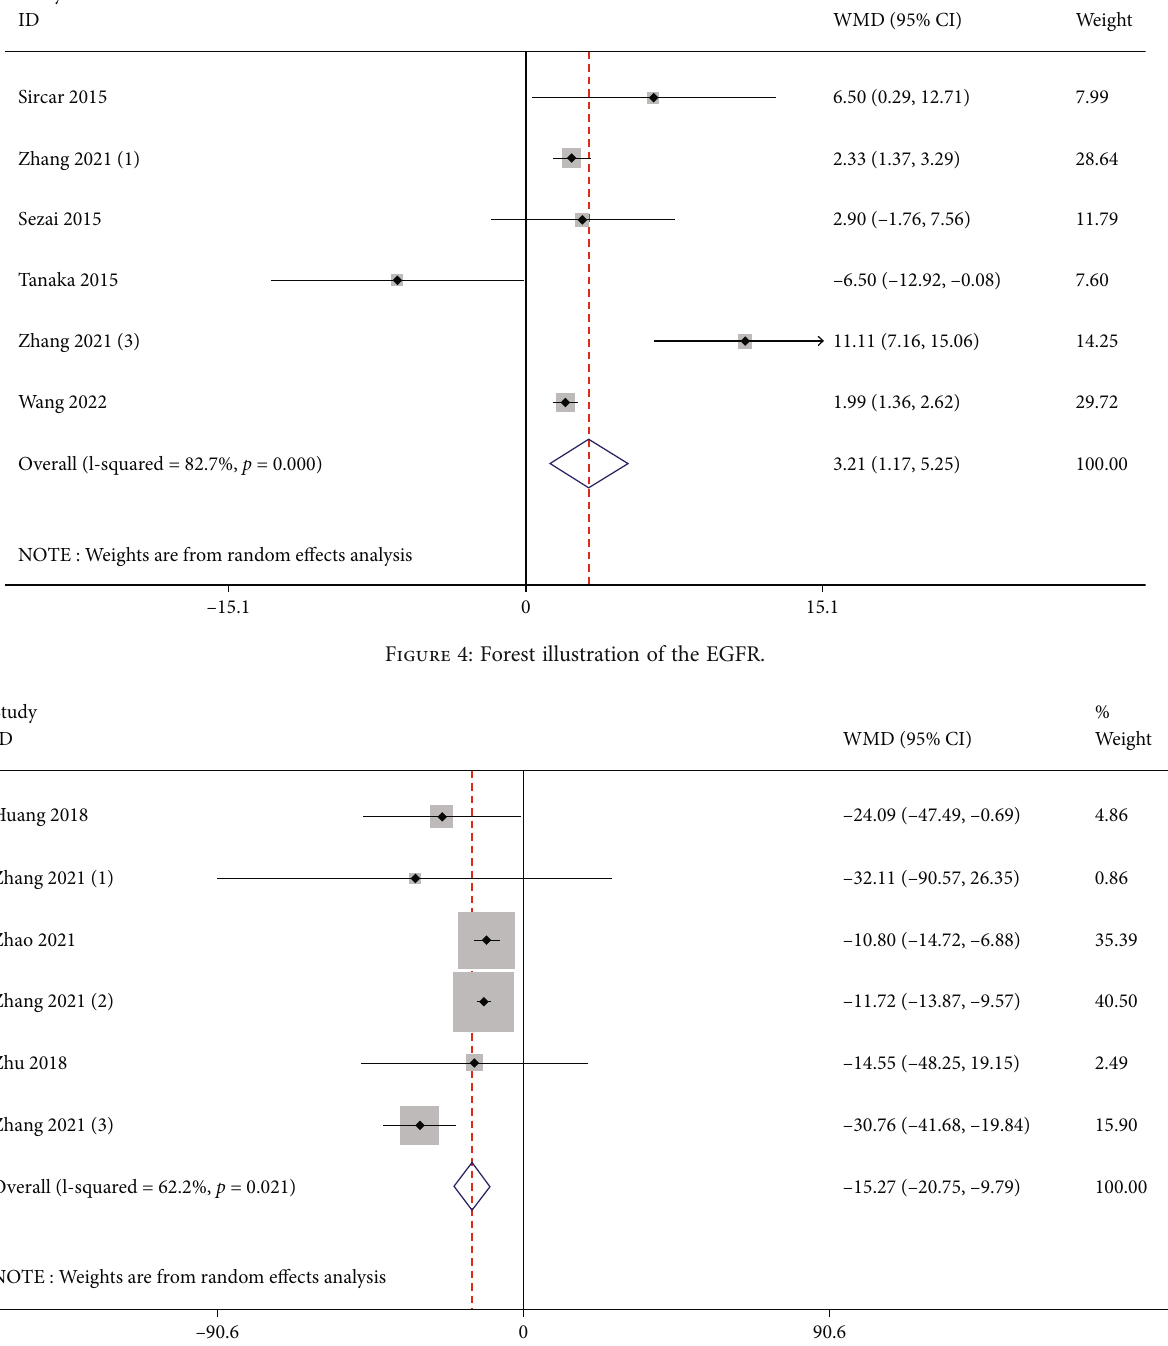
Figure 5: Forest illustration of the serum